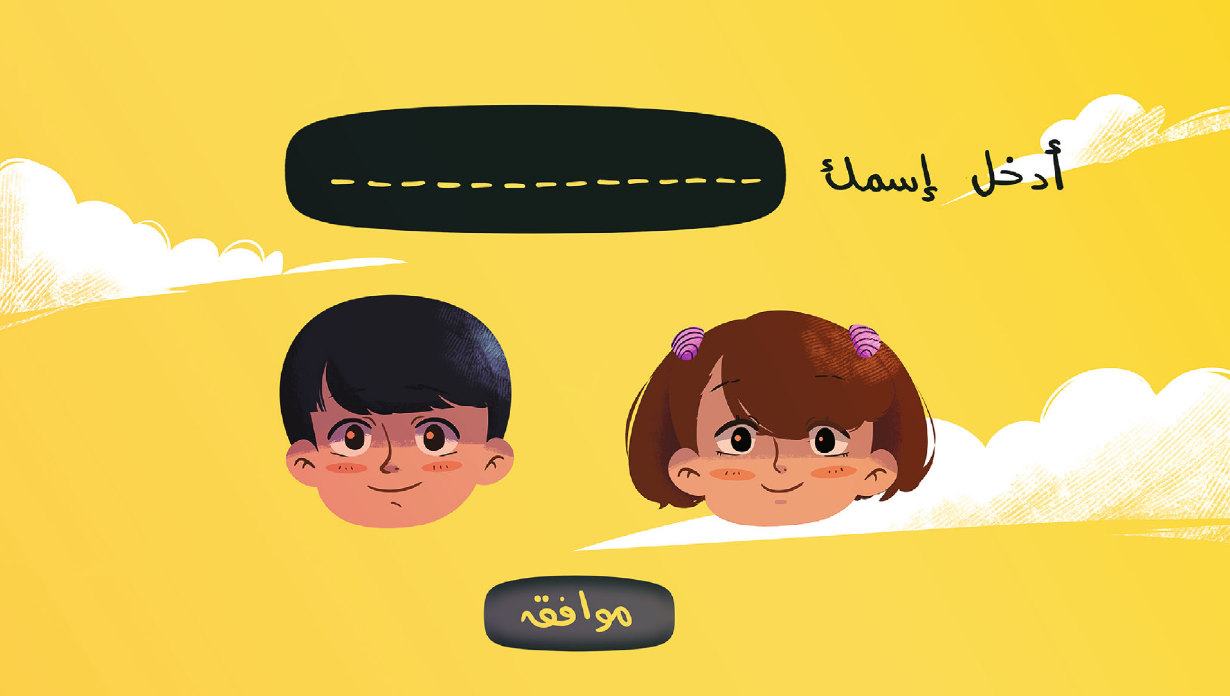
Figure 1: App login screen.